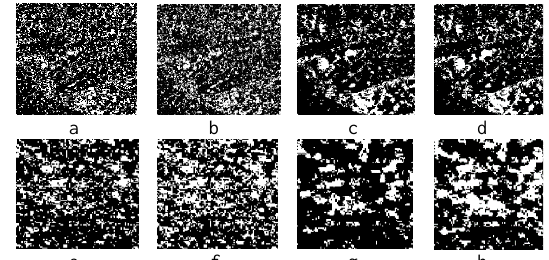
h Figure 6. Output change map in ED algorithm for Data 1